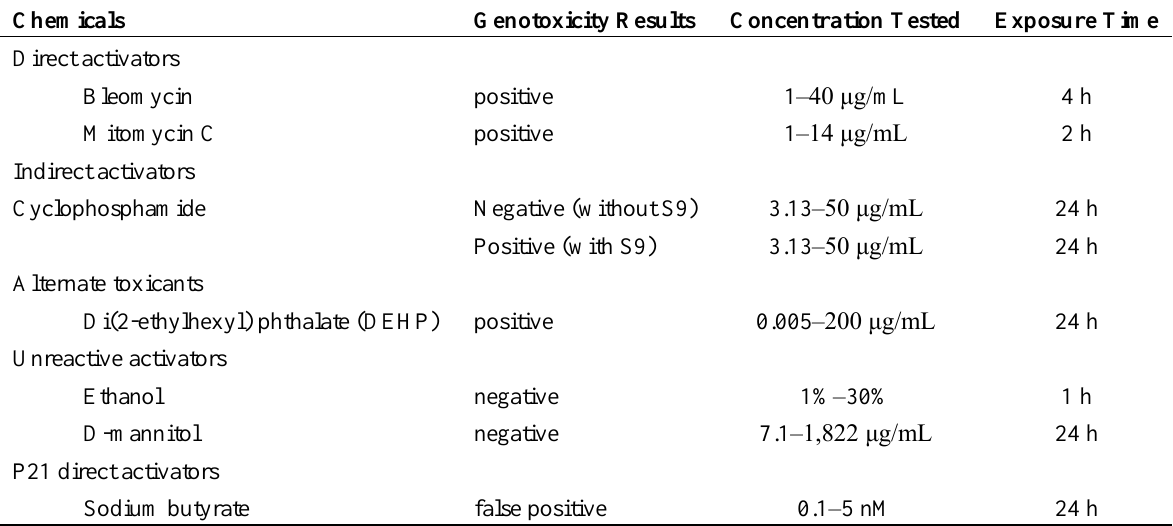
Table 1. Summary of the genotoxicity detection results using the fish cell biosensor system